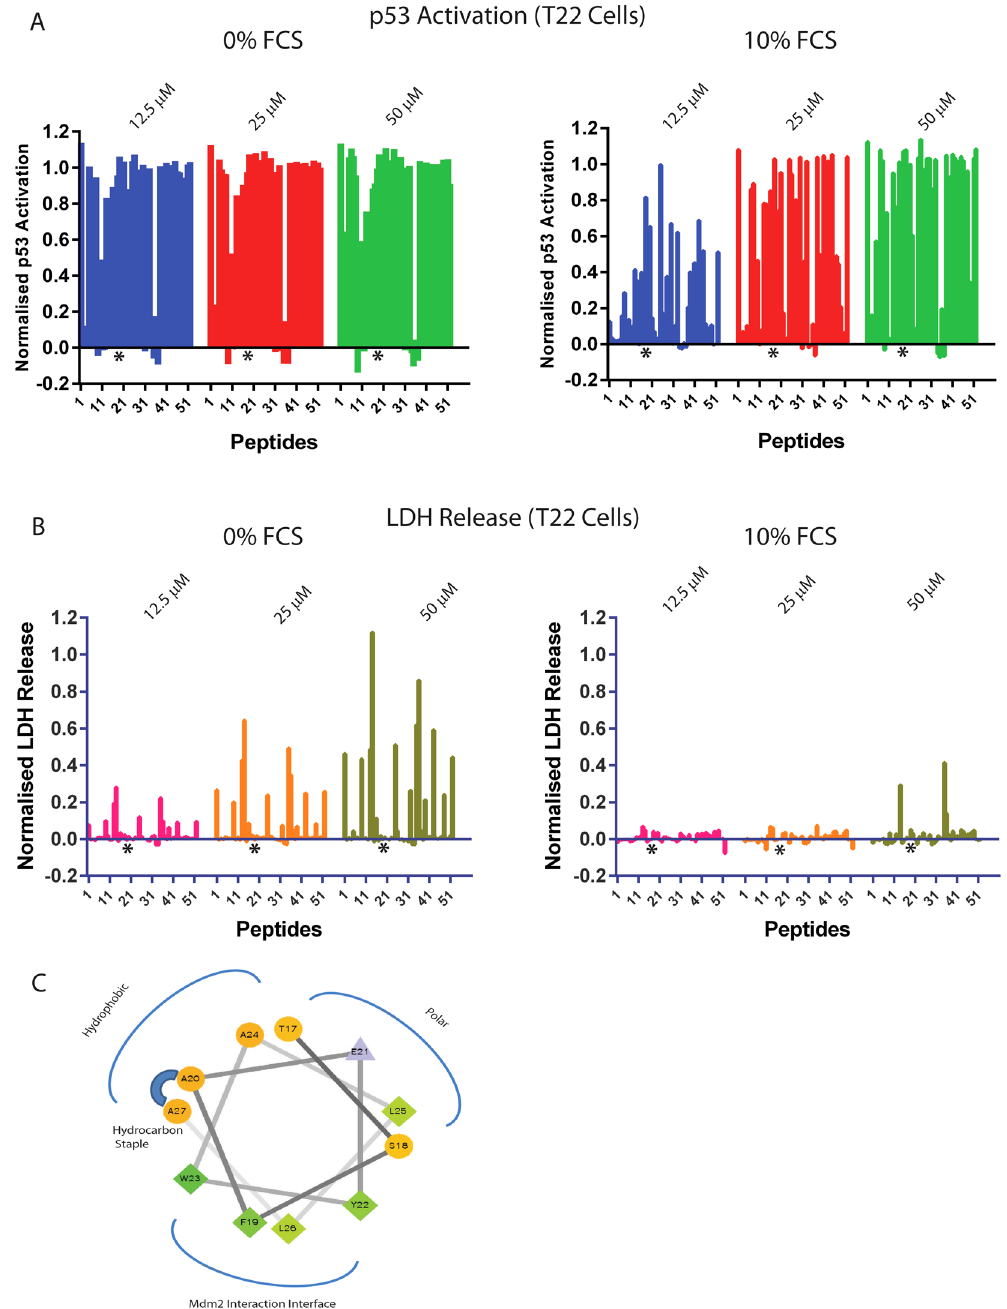
Figure 1. ( A ) Results for the screening of a 52 membered stapled peptide library using the T22 p53 reporter cell based assay. The library was screened either in the presence (10%) or absence of FCS (fetal calf serum) at 3 different concentrations to capture weak and strong inducers of p53 activation. ( B ) Results for screening the library using the CYTO-TOX LDH release assay (Promega) to assess for membrane destabilization. The library was screened either in the presence (10%) or absence of FCS at three different concentrations to capture weak and strong LDH releasers. ( C ) A helical wheel representation of the sMTIDE-02 template sequence used for the design of the peptide library. The peptides in the library are amphipathic in nature with a hydrophobic aliphatic chain running down one face of the helix, the hydrophobic Mdm2 conserved binding motif running down the other and the remainder of the molecule being slightly more polar in character. * indicates the location of VIP- 82 amongst the stapled peptides